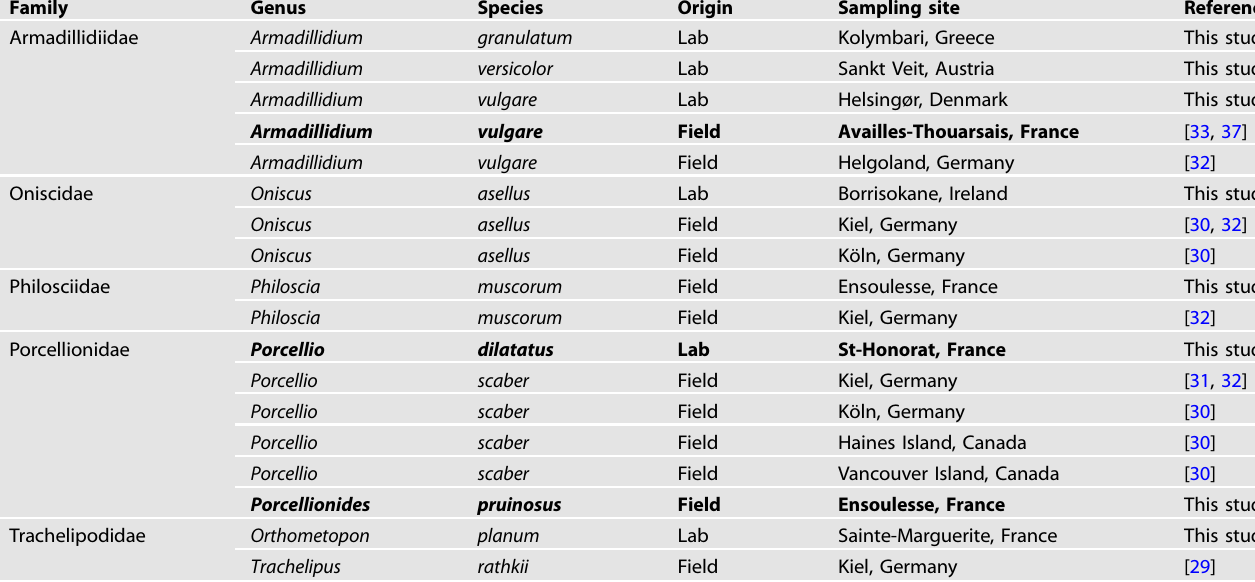
The populations used for genome sequencing are indicated in bold.